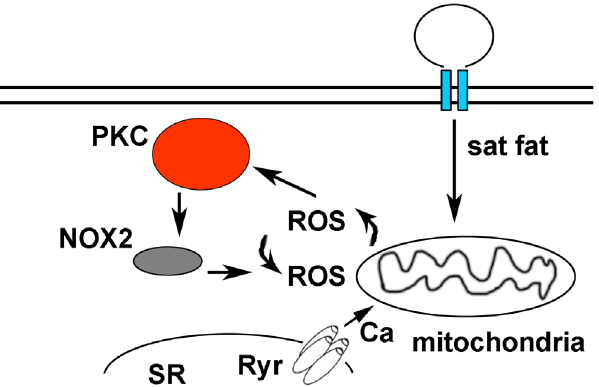
Fig 8. Diagram of proposed pathway. Saturated fats are internalized by cardiomyocytes and transported to the mitochondria to be used as a fuel source for beta-oxidation, causing a low level of mitochondrial ROS. This activates PKC, which in turn activates NOX2. ROS from NOX2 and mitochondrial ROS amplify each other in a feed-forward cycle that promotes greater ROS production and sarcoplasmic reticulum (SR) calcium